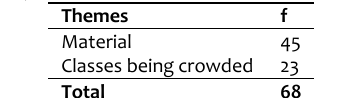
Table 6. Problems experienced during the application of the science and mathematics